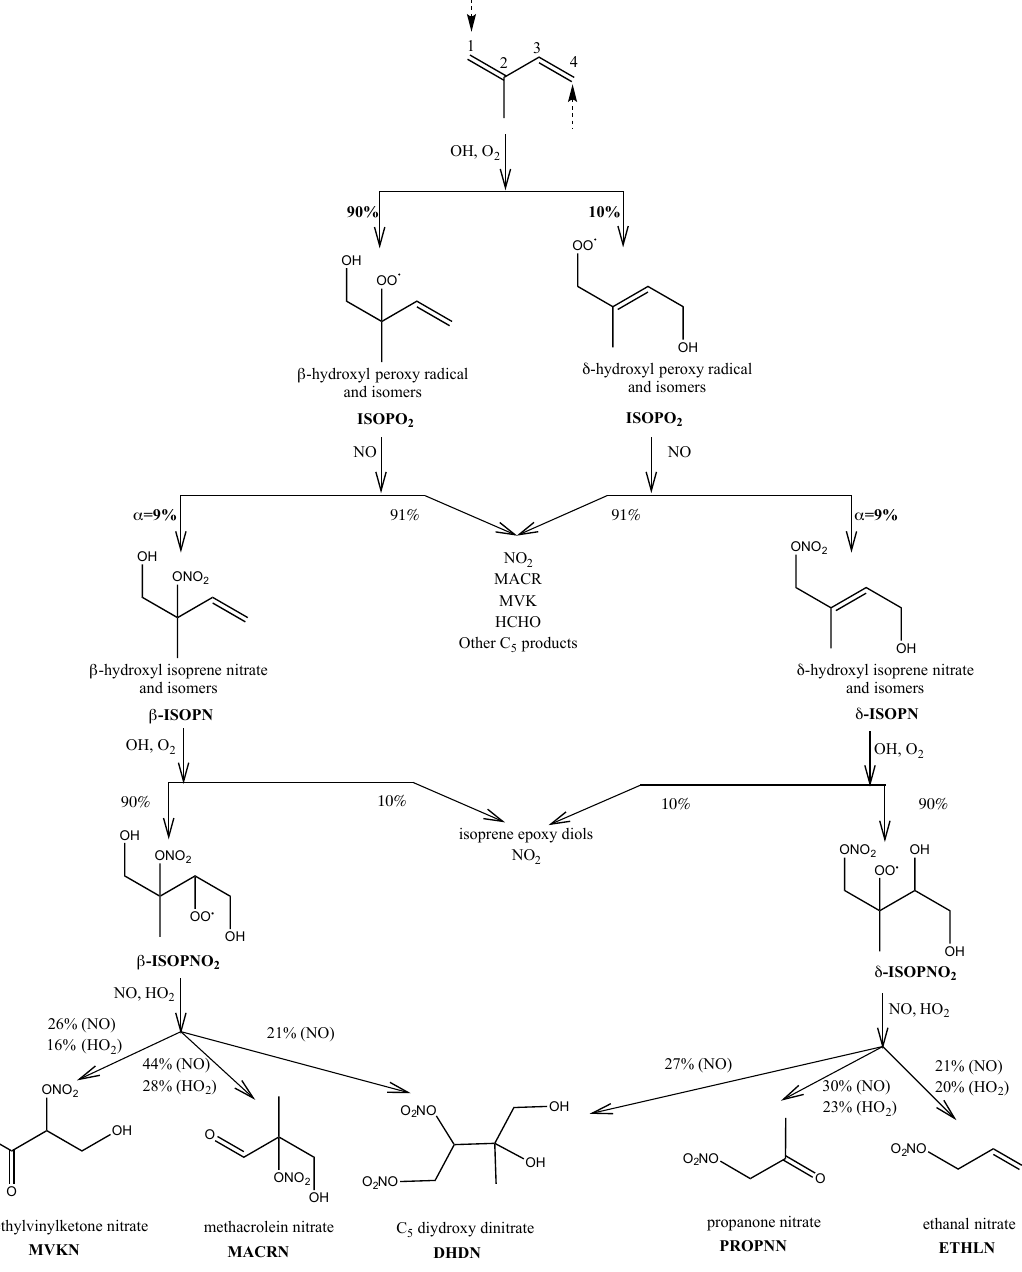
Figure 2. Schematic of the formation of isoprene nitrates (INs) from OH-initiated isoprene oxidation as implemented in GEOS-Chem. The isomers shown are indicative as the mechanism does not distinguish between isomers (except for β - vs. δ -configurations). For ISOPNO 2 oxidation, only IN products are shown, along with their yields from both NO and HO 2 pathways. Small yields ( < 10%) of MVKN and MACRN from δ -ISOPNO 2 are not